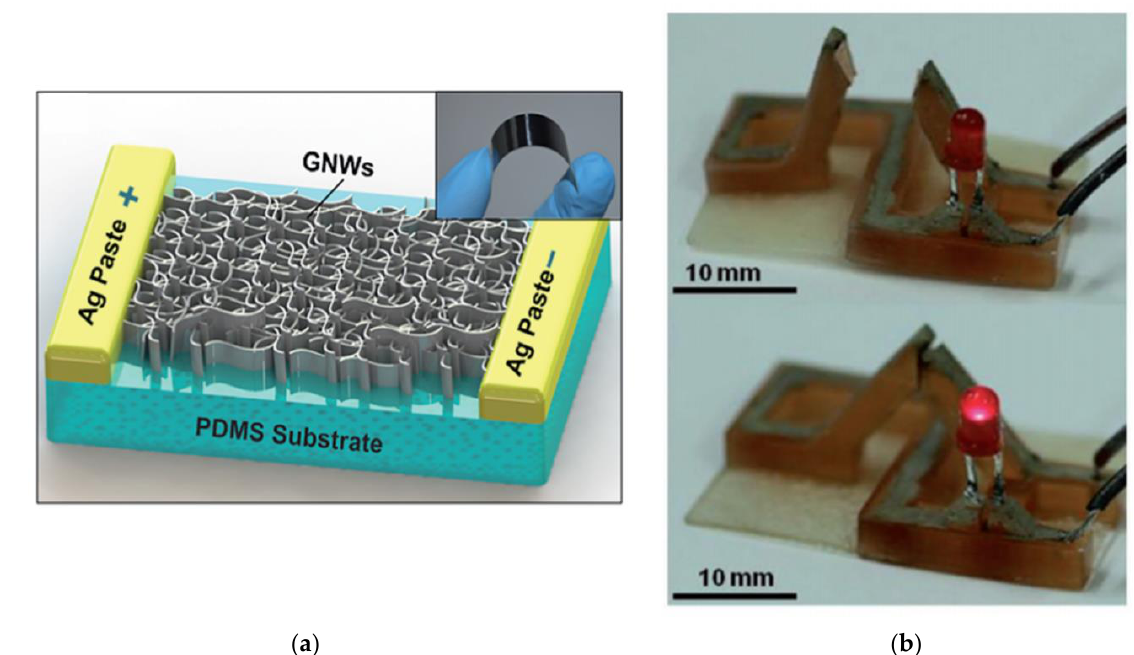
Figure 5. Flexible sensors based on nanomaterial and a polymer. ( a ) PDMS/Ag nanoparticles on PDMS layer, reprinted with permission from [48]. ( b ) Carbon nanomaterials on a shape memory polymer capable of detecting temperature changes by opening/closing an LED circuit. The sensor changes shape when the temperatures rises/falls, thereby switching a circuit on/off, reprinted with permission from [59].